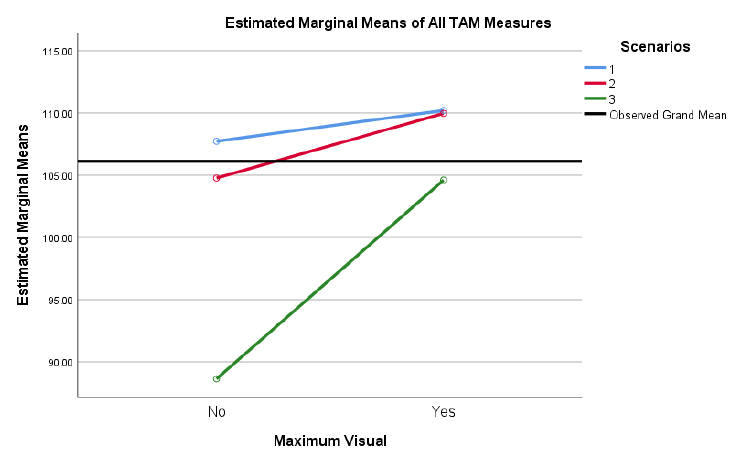
Figure 5. Estimated marginal means of all